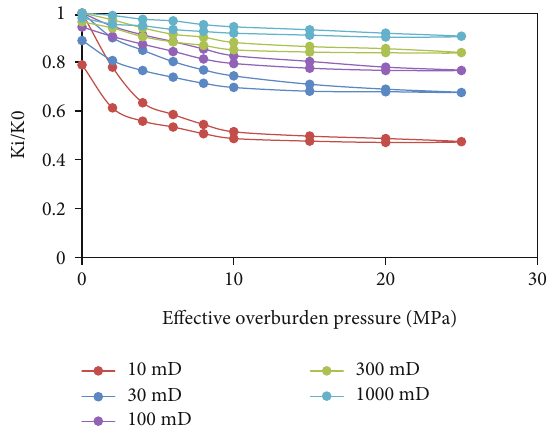
Figure 3: The variation of permeability of di ff erent core permeability with e ff ective overburden